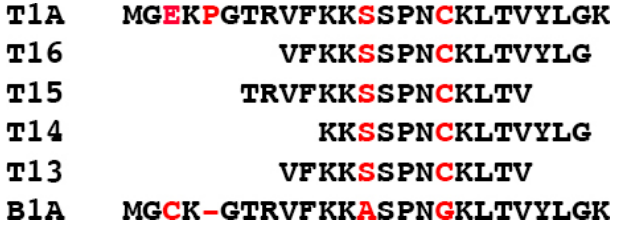
Figure 1. Peptide sequences. The sequence of T1A, shorter T1A-derived peptides, and B1A (homol- ogous to the T1A element of arrestin-2). The residues that are different in arrestin-2 and arrestin-3 are shown in red.